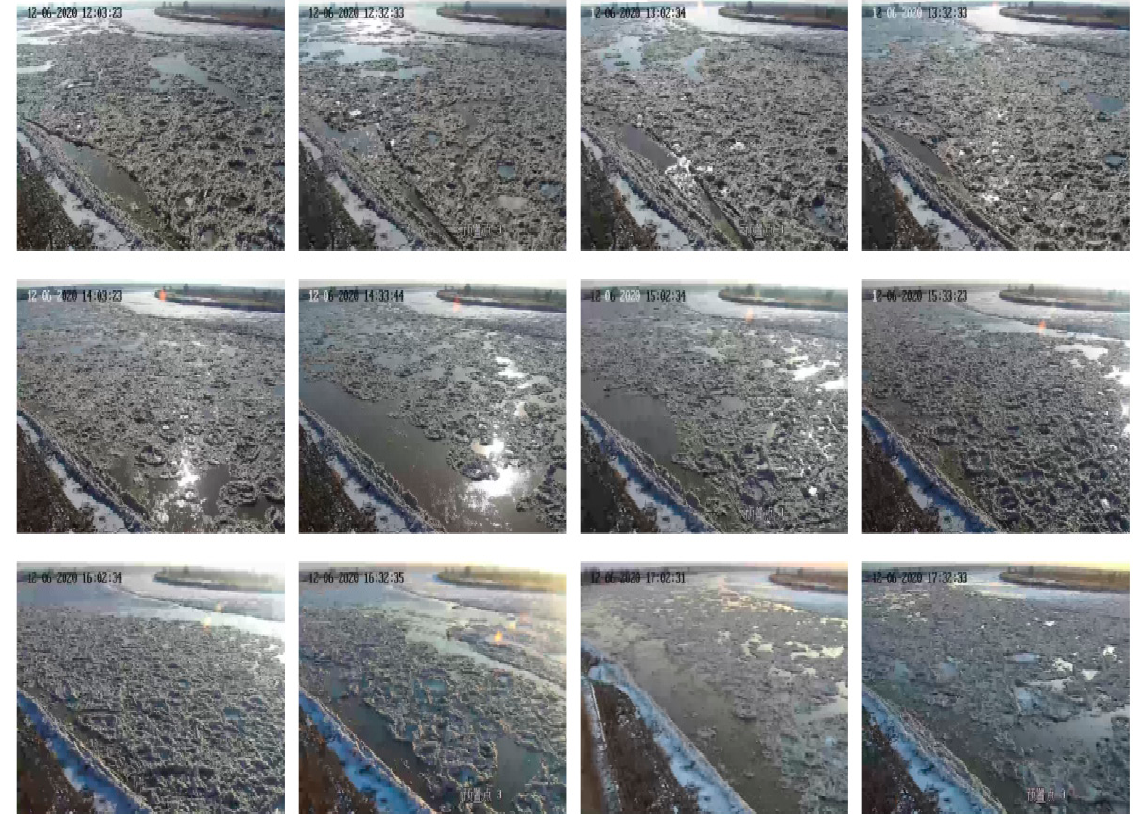
Figure 9. Flow ice scenes in different times of the Shisifenzi reach on 6 December.